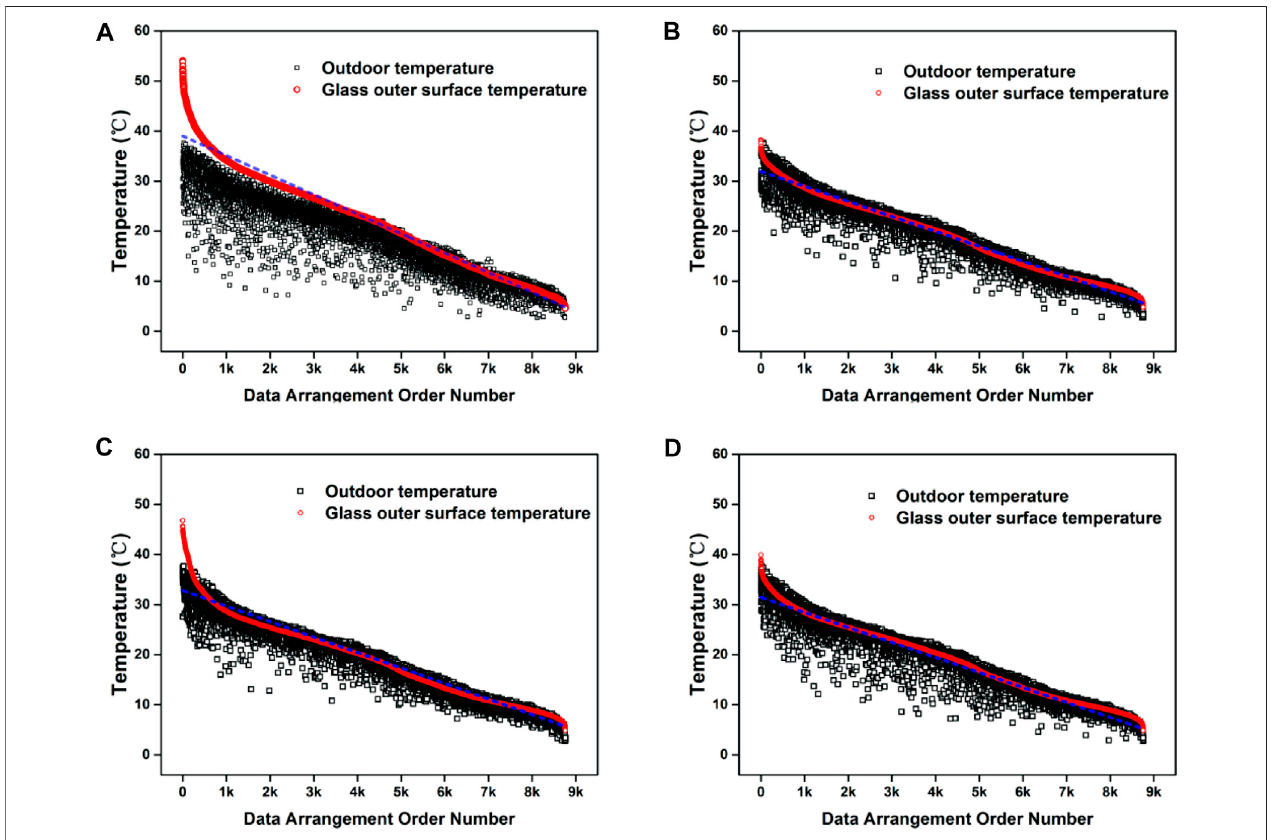
FIGURE 4 | Temperature distribution of skylight (A) , east (B) , west (C) , and south windows (D) outer surface and outdoor air temperature in Chongqing area. The blue dotted line is the linear regression curve of the outer surface temperature of the skylight.